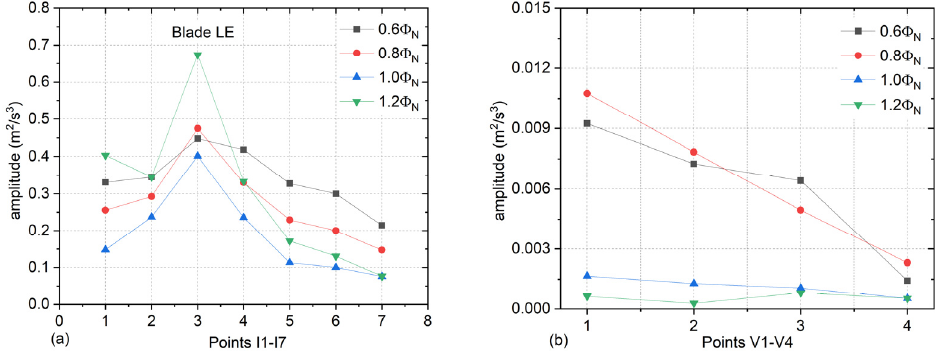
Figure 9. Velocity amplitude at f BPF of different measuring points under four typical flow rates, ( a ) velocity amplitudes at points I1–I7 and ( b ) velocity amplitudes at points V1–V4.